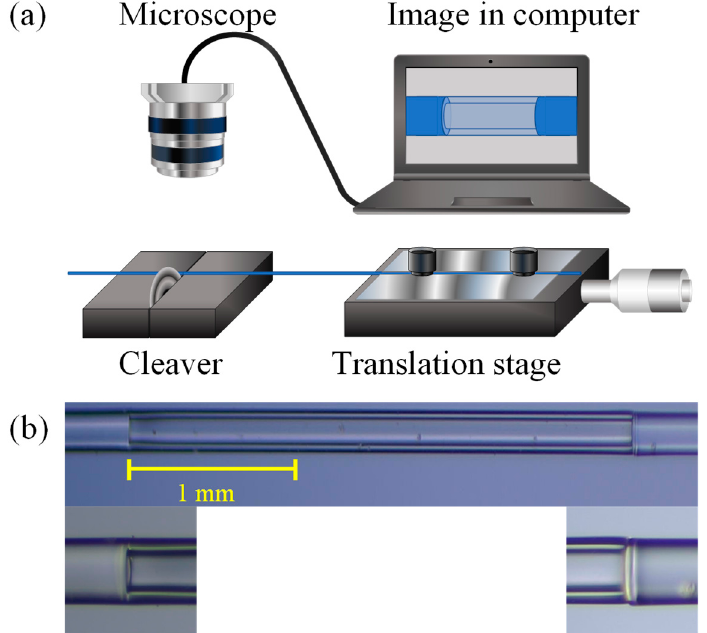
Figure 8. ( a ) Experimental setup for cutting a segment of MMF or CHCF accurately. ( b ) Lateral view of the fabricated device and the splicing section between MMF and CHCF.